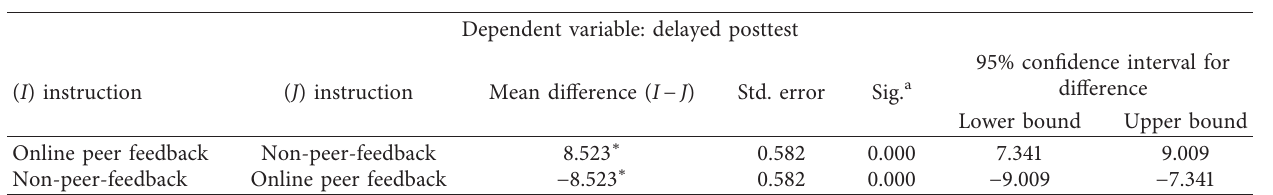
Table 11: Pairwise